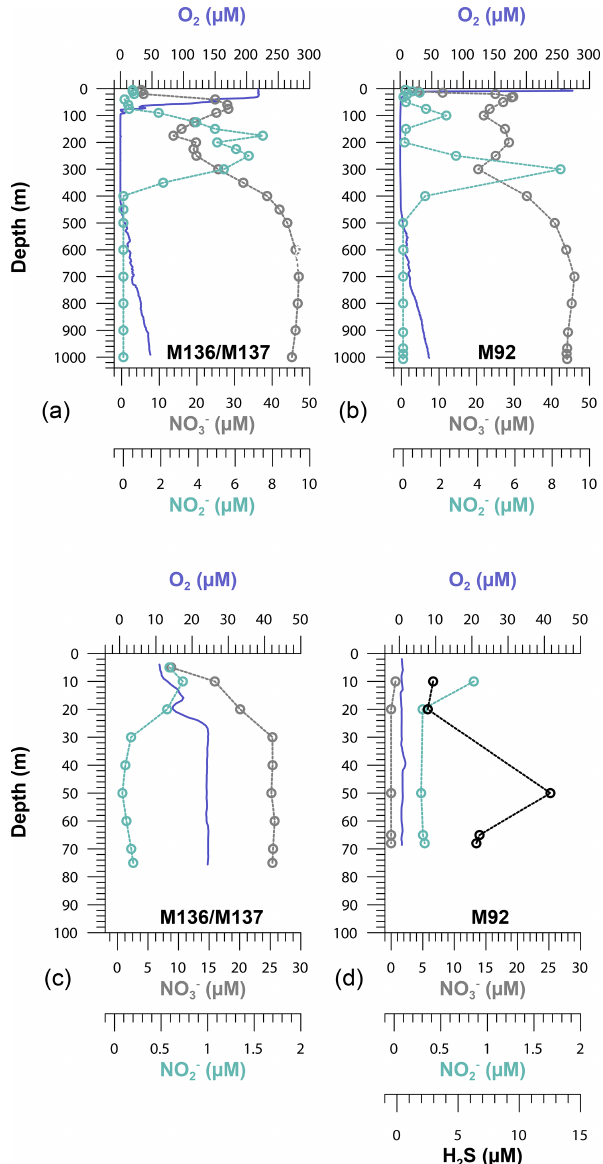
Figure 2. Oxygen (O 2 ), nitrate (NO − gen sulfide (H 2 S) concentrations on the Peruvian slope (Station 10, 1000m depth), crossing the oxygen minimum zone (a, b) , and the upper shelf (Station 1, 75m depth) (c, d) during cruises M136– M137 and M92 along the 12 ◦ S transect.